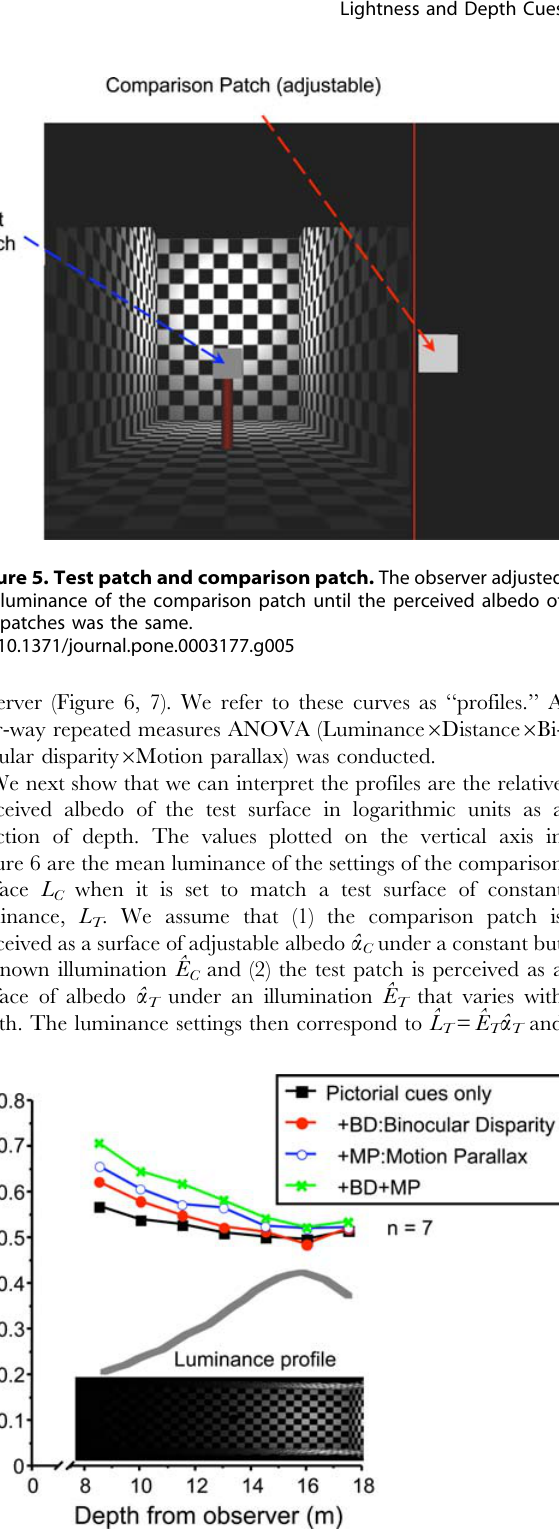
Figure 6. Discounting effects across depth cue conditions. The logarithm of luminance is plotted versus depth for each of the depth cue conditions, pictorial cues only (black solid square), pictorial cues and binocular disparity (red solid circle), pictorial cues and motion parallax (blue circle), pictorial cues, binocular disparity and motion parallax (green cross). The conditions of test surface luminance were merged here. The negative slopes indicate discounting of lightness. Luminance profile of the floor is superimposed. See text.